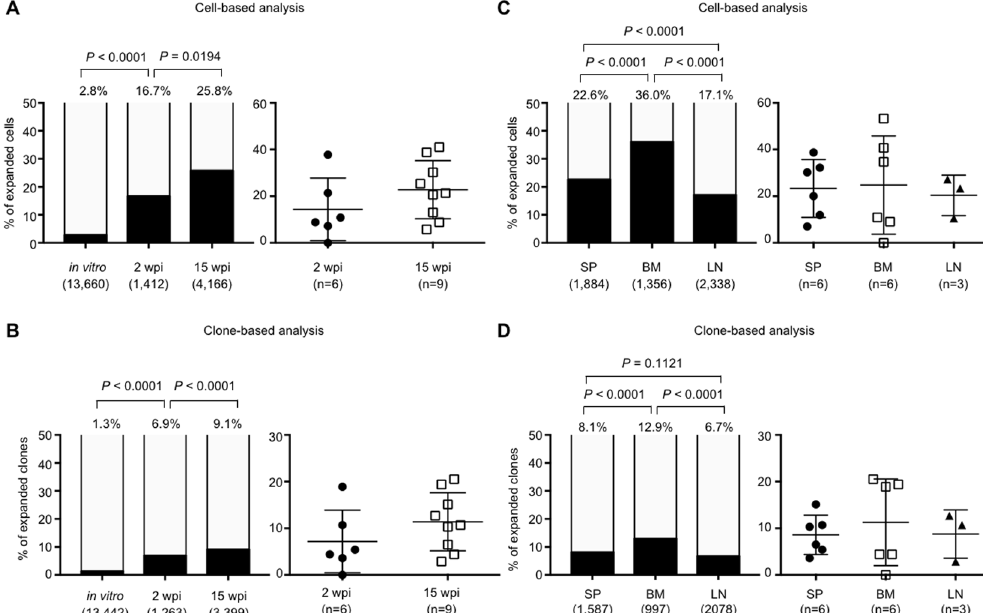
Figure 2. Cell-based and clone-based integration site analysis. ( A ) The percentages of expanded cells within the total number of infected cells were analyzed using genomic DNAs from tissues of 2 wpi or 15 wpi mice. DNA extracted from Jurkat cells infected with HIV-1 in vitro was analysed as a control. Cumulative data are shown in the left panel. The value for each individual mouse is shown in the right panel. ( B ) Clone-based analysis of 2 wpi or 15 wpi mice. ( C ) Comparison of the degree of clonal expansion at different tissues. Cumulative results of cell- based analysis are shown in the left panel, and the value of each individual mouse is shown in the right panel. ( D ) Clone-based analysis is also shown. The number of infected cells or clones in each sample is shown under the graph of the left panel. The number of mice or tissues analysed is shown under the graph of the right